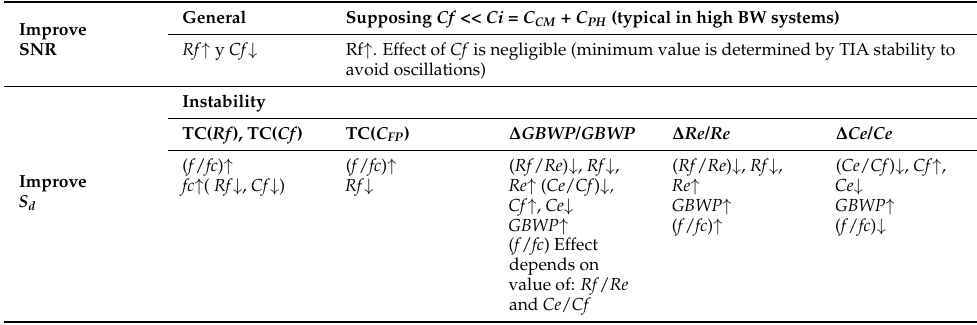
Table 1. Effect of the circuit parameters on SNR and distance stability. Re = R CM // R DM // R PH , Ce = C CM + C DM + C PH (see Figure